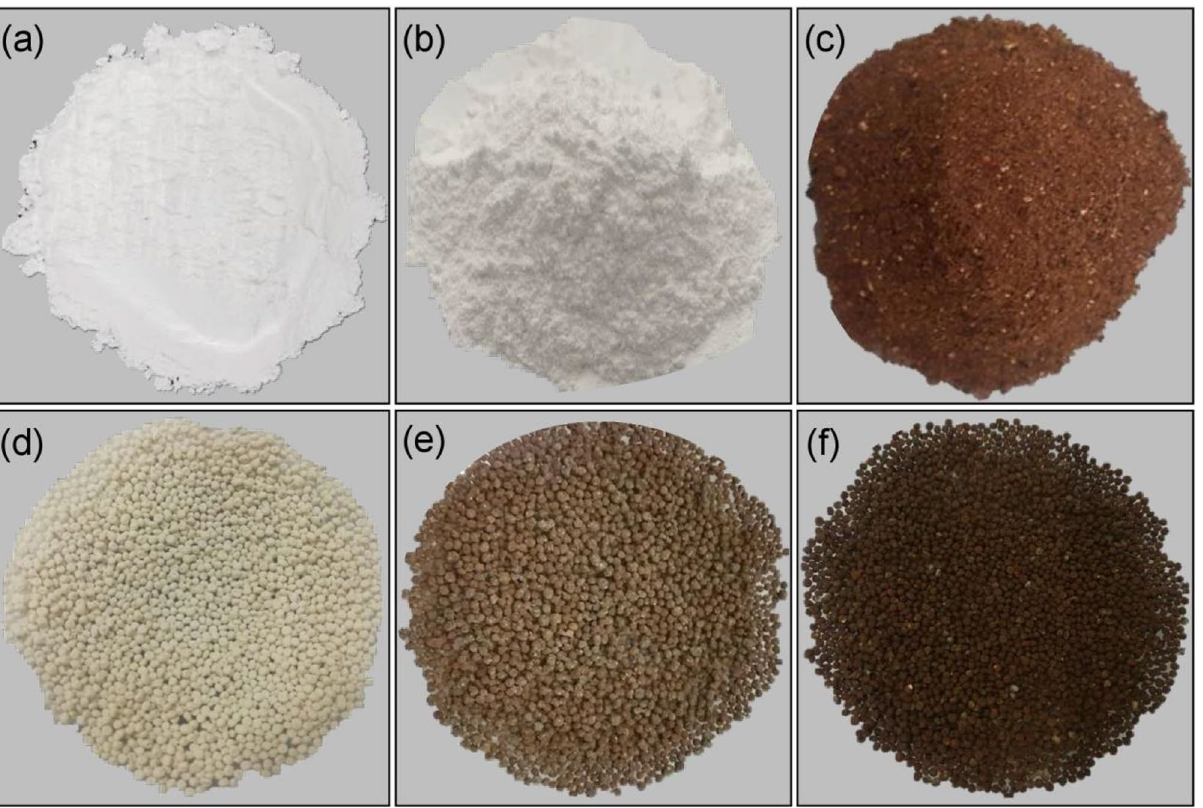
Figure 1. The physical characteristics of ( a ) zeolite A standard (STD), ( b ) zeolite A sugarcane bagasse fly ash powder (ZB), ( c ) zeolite A sugarcane bagasse fly ash powder mixed iron(III) oxide-hydroxide (ZBF), ( d ) zeolite A sugarcane bagasse fly ash beads (ZBB), ( e ) zeolite A sugarcane bagasse fly ash powder mixed iron(III) oxide- hydroxide beads (ZBFB), and ( f ) zeolite A sugarcane bagasse fly ash beads coated iron(III) oxide-hydroxide (ZBBF).